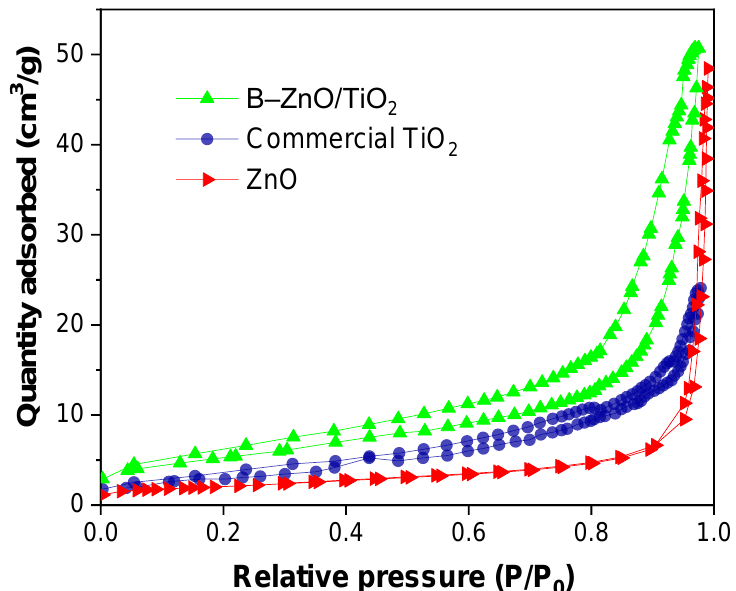
Catalysts 2022 , 12 , x FOR PEER REVIEW Figure 5. Nitrogen adsorption – desorption isotherms of TiO 2 , ZnO, and B – ZnO/TiO 2 . Figure 5. Nitrogen adsorption–desorption isotherms of TiO